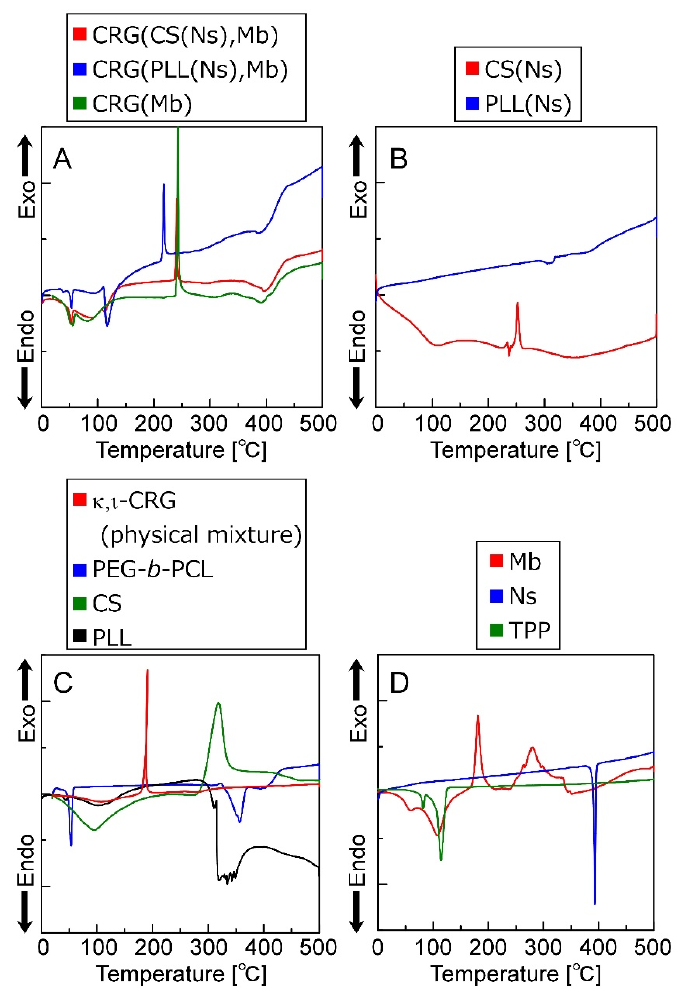
Figure 6. DSC thermograms (0–500 °C) of ( A ) microparticles, ( B ) nanoparticles, ( C ) polymers that form the particles and ( D ) low-molecular-weight molecules that form the microparticles and were encapsulated in the